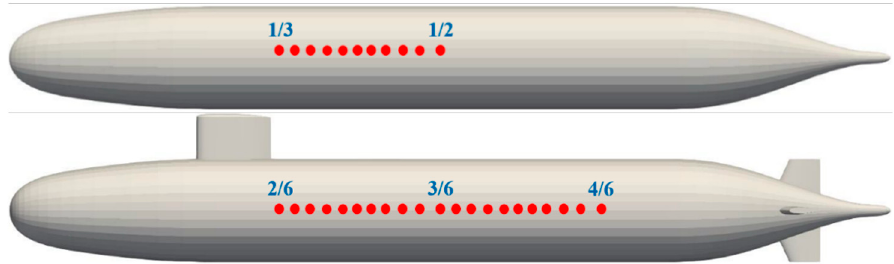
Figure 18. Schematic diagram of the SUBOFF rotation centre position. Table 5. Specific values of the position of the centre of rotation ( S ). S ( x / L s